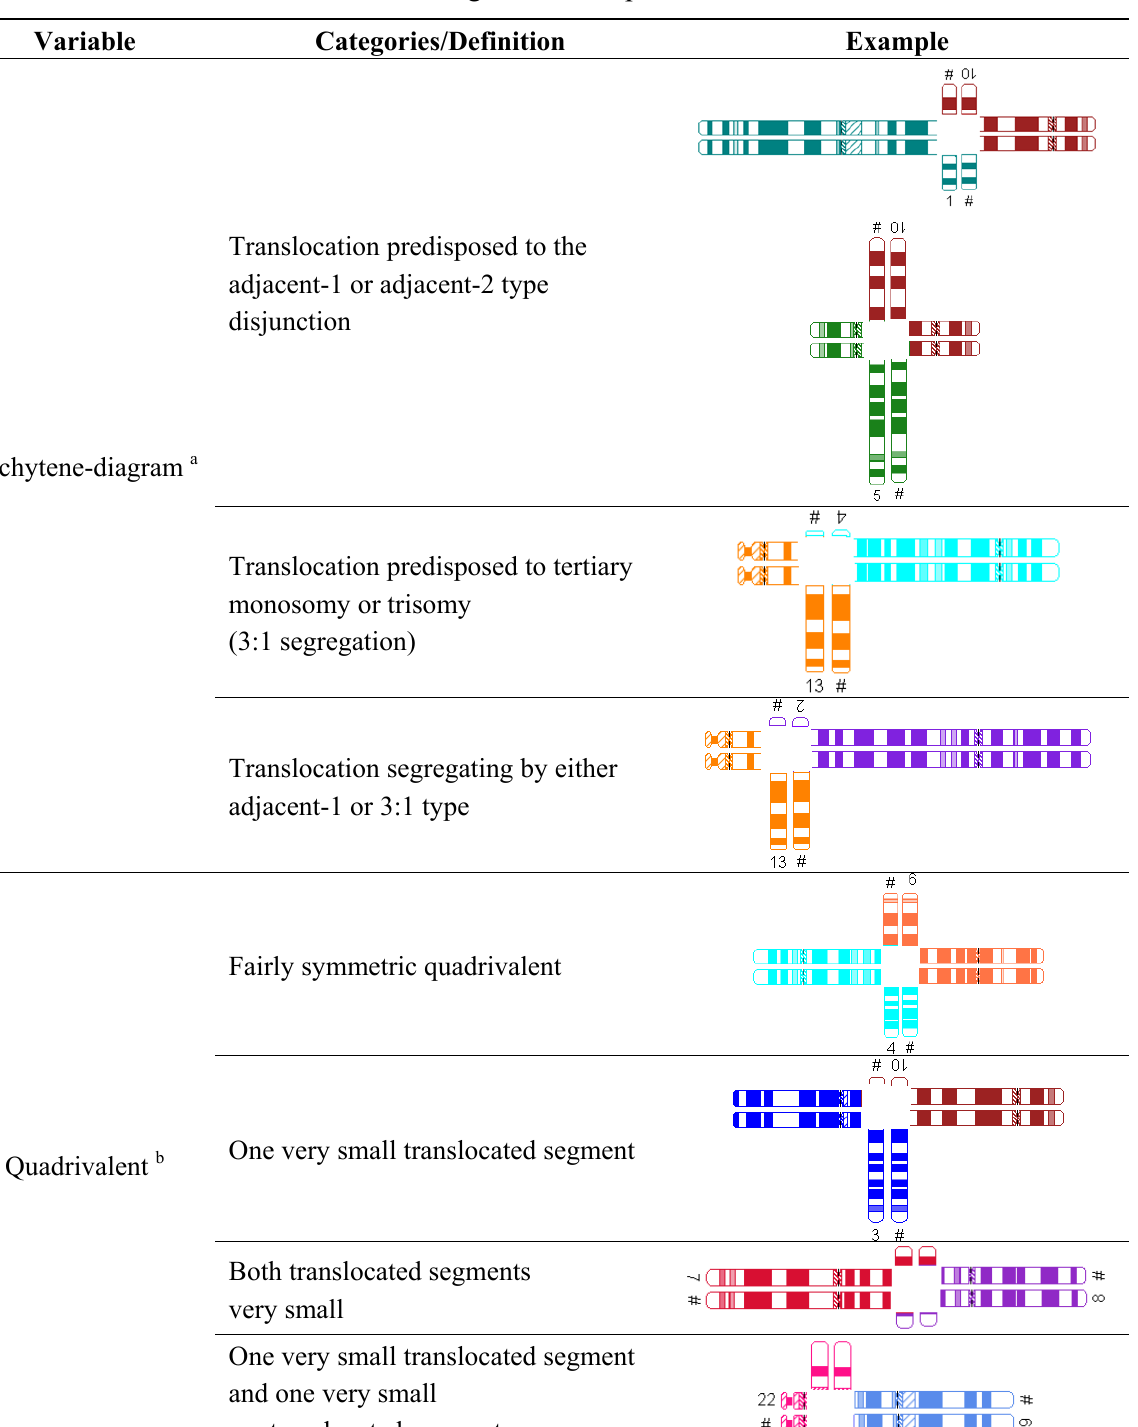
Table 1. Possible categories of reciprocal